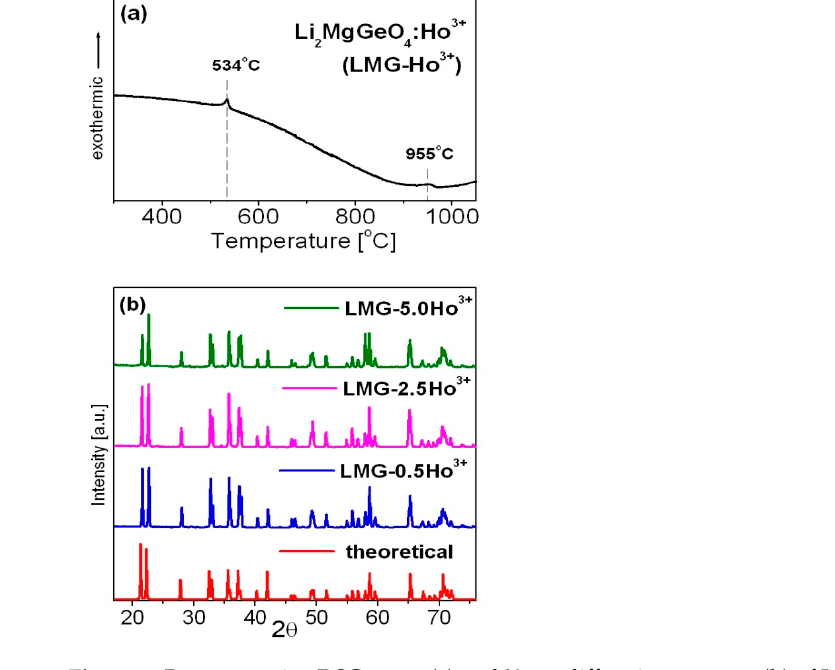
Figure 1. Representative DSC curve ( a ) and X-ray diffraction patterns ( b ) of LMG-Ho 3+ . Li 2 MgGeO 4 :Ho 3+ germanate ceramics (LMG-Ho 3+ ) show two phase transitions [30]. The low-temperature phase transition near T = 534 ◦ C is related to insignificant